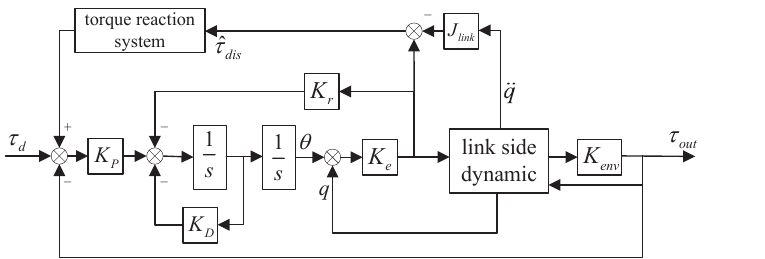
Figure 11. Structural diagram of resonance proportional force control with disturbance compensation.